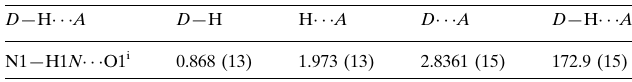
Hydrogen-bond geometry (A˚ , (cid:1)